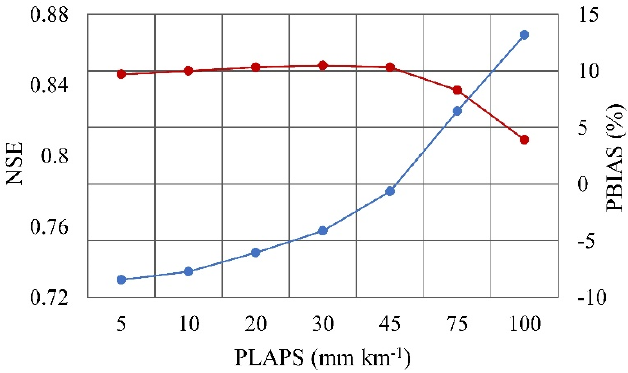
Figure 10. Sensitivity analysis of precipitation gradient to runoff